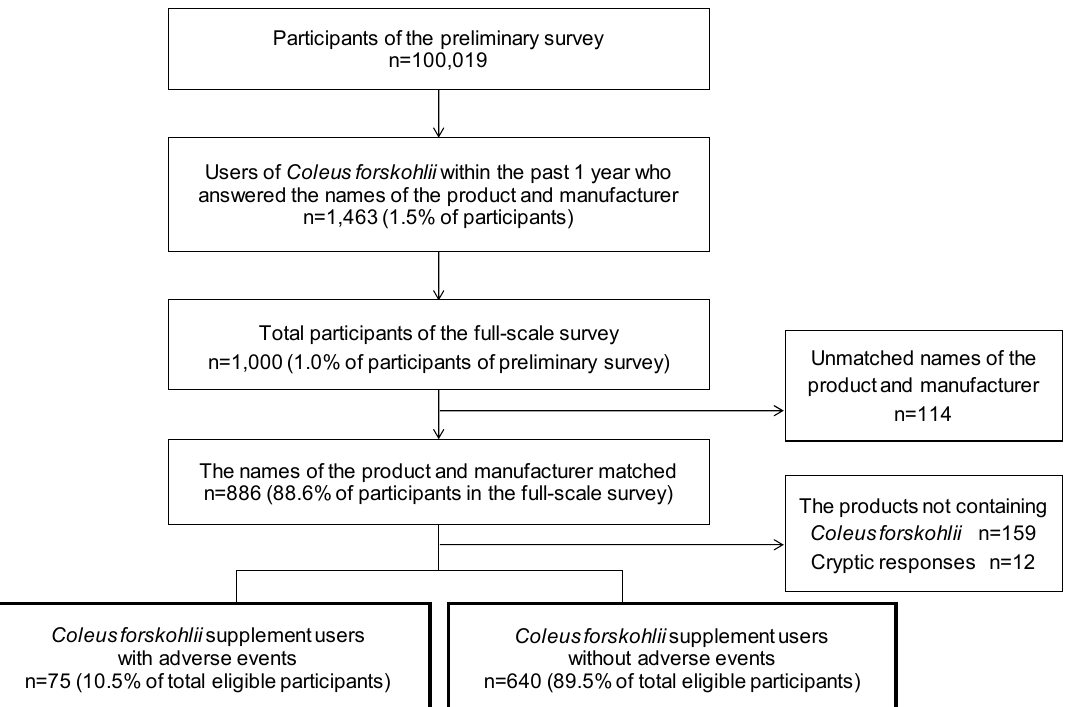
Figure 1. Flow diagram for the selection of study participants.